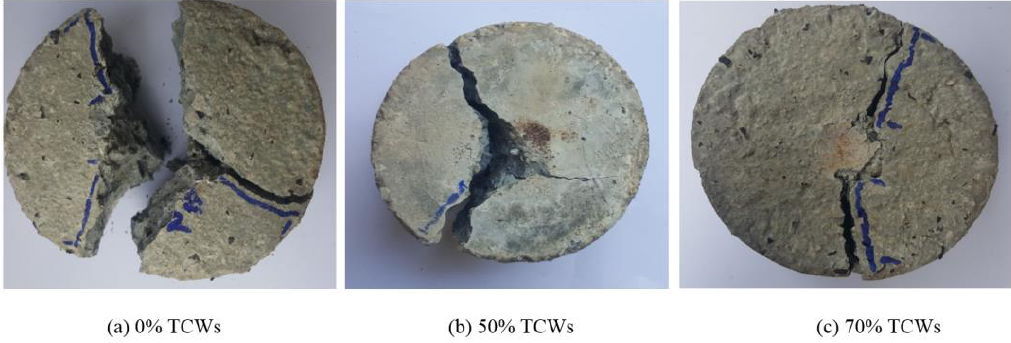
Figure 16. Fracture pattern of high TCWs-based GPMs.